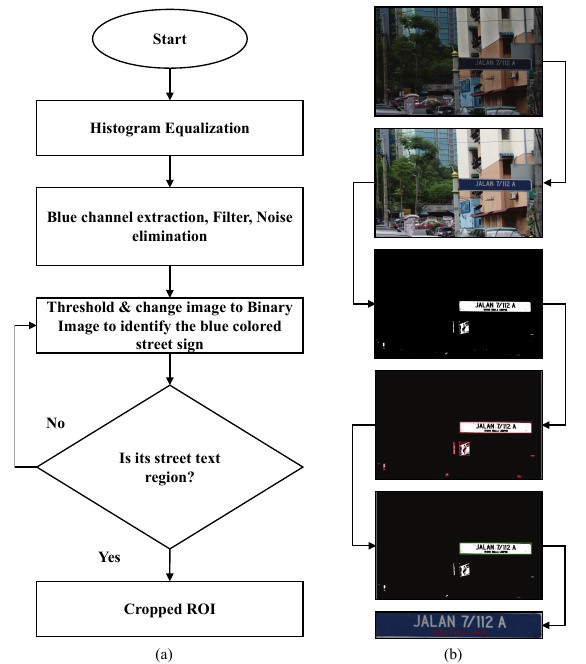
Figure 3. Extraction of the region of interest: ( a ) block diagram of the algorithm and ( b ) results at each step.